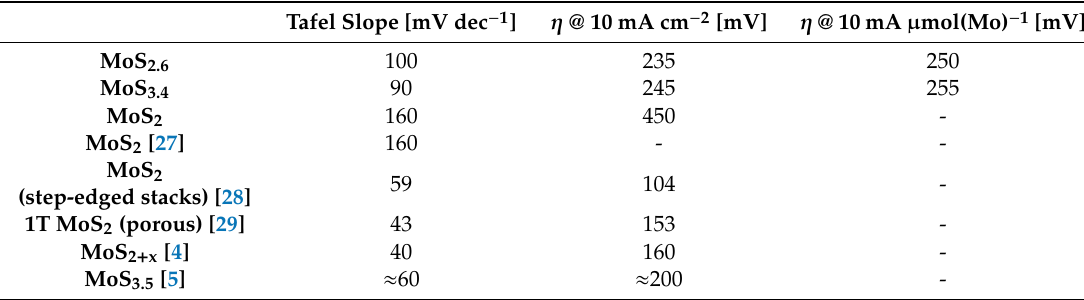
Table 1. Tafel slopes and overpotentials at 10 mA cm − 2 of MoS x and MoS 2 .